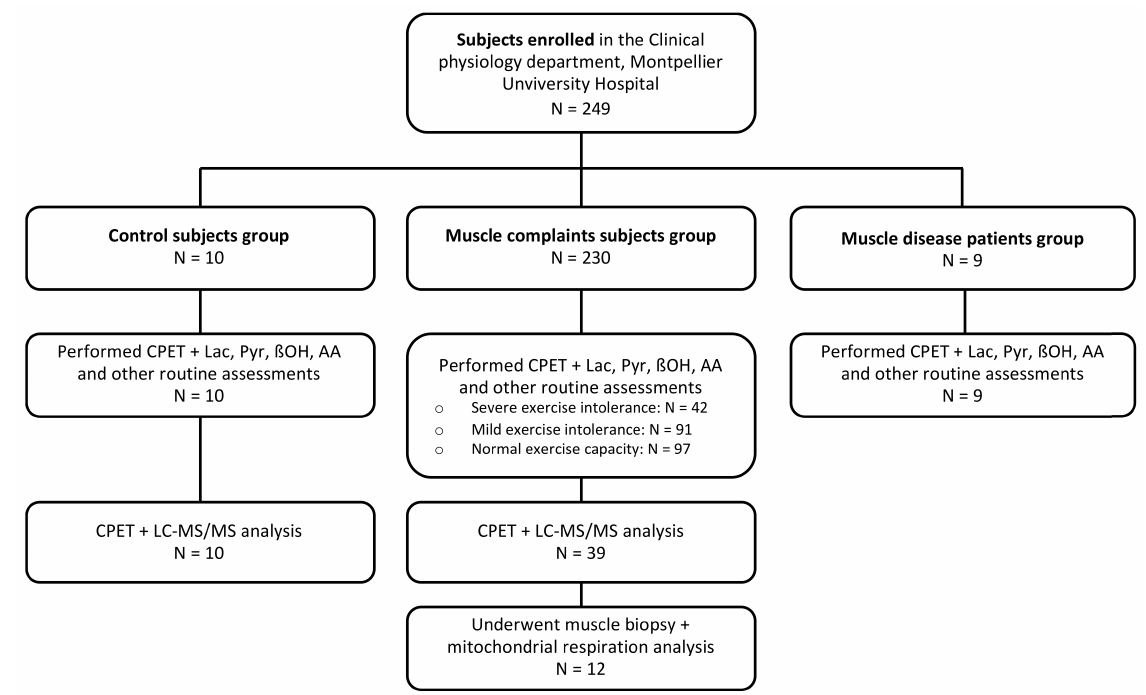
Figure 1. Flow-chart diagram of the studied subjects and assessments. AA: Acetoacetate; ßOH: beta- hydroxybutyrate; CPET: cardiopulmonary exercise test; Lac: lactate; LC-MS/MS: chromatography liquid tandem mass spectrometry; Pyr: